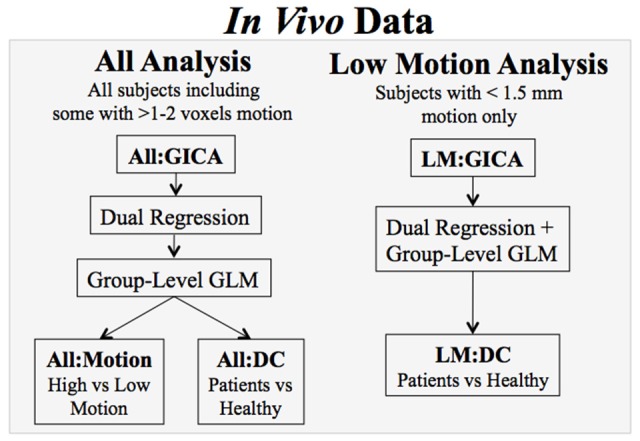
Analyses of the in vivo data. Two different GICA-DR analyses were done, one that included all subjects, regardless of level of motion (All), and a second that included participants with <1.5 mm motion in any direction (Low Motion). Different group level models were conducted to assess motion effects, e.g., with participants grouped either by level of motion or by diagnostic category (DC).